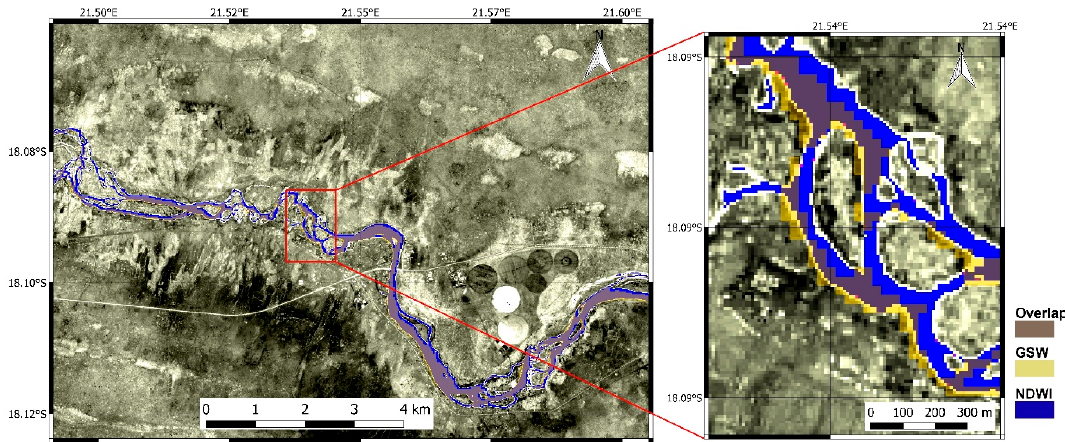
Figure 5. Comparison C: Okavango at Divundu GSW for September 2015 (orange) with Sentinel-2A L1C NDWI (blue >0.5) from 18 September 2015 and overlap (grey).